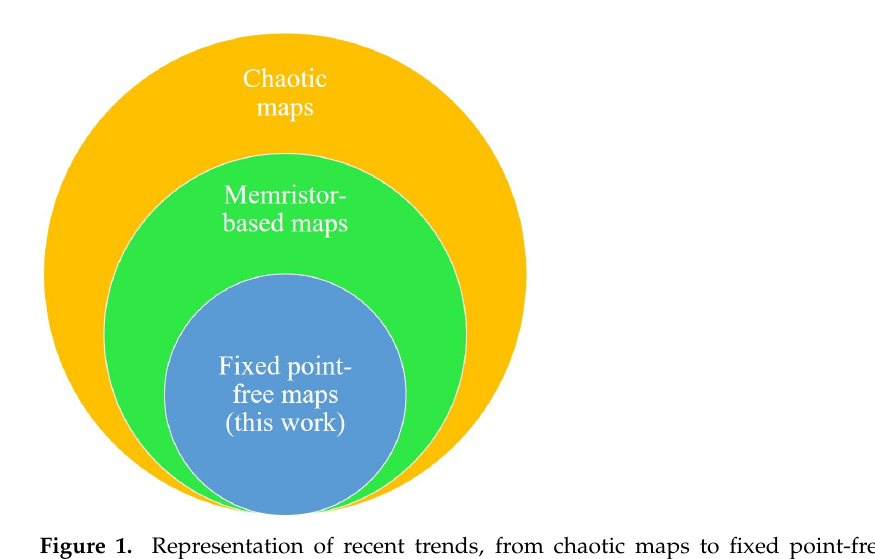
Figure 1. Representation of recent trends, from chaotic maps to fixed point-free maps based on